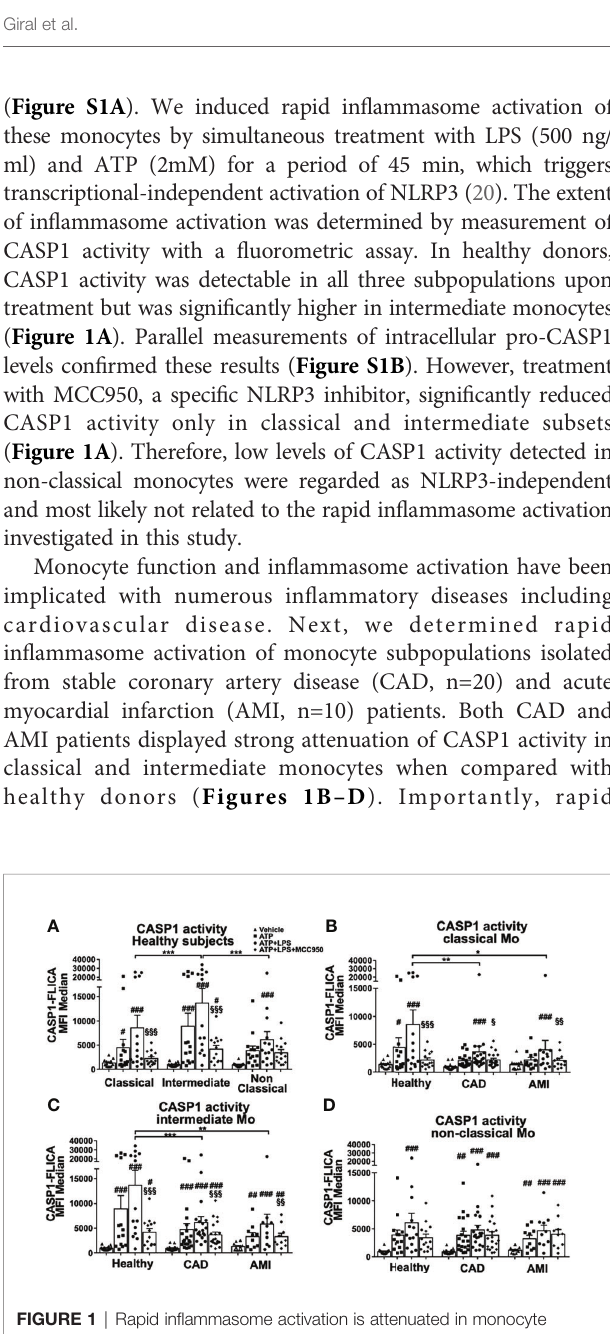
( Figure S1A ). We induced rapid in fl ammasome activation